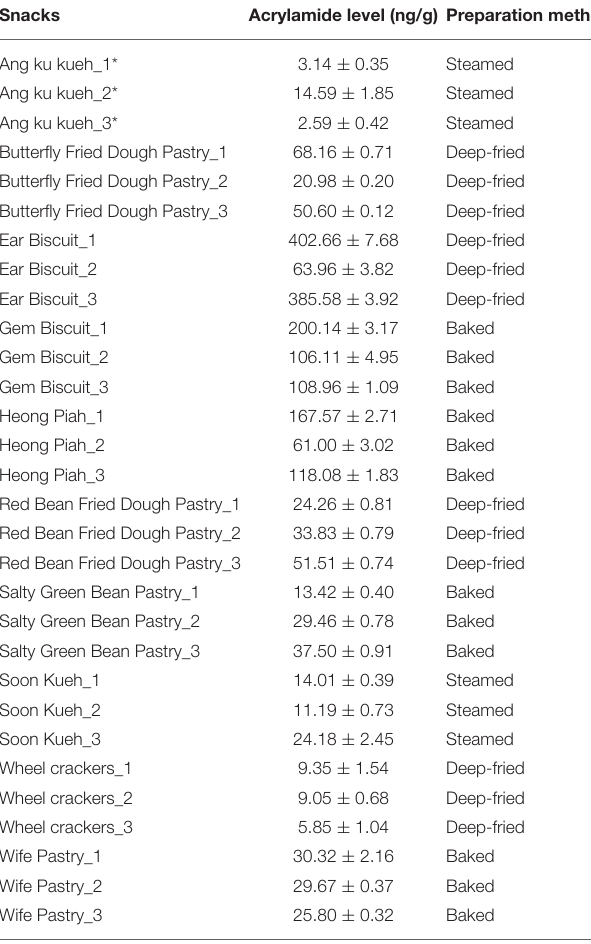
TABLE 3 | Acrylamide levels (ng/g) in commonly consumed local Chinese snacks with three replicates. Snacks